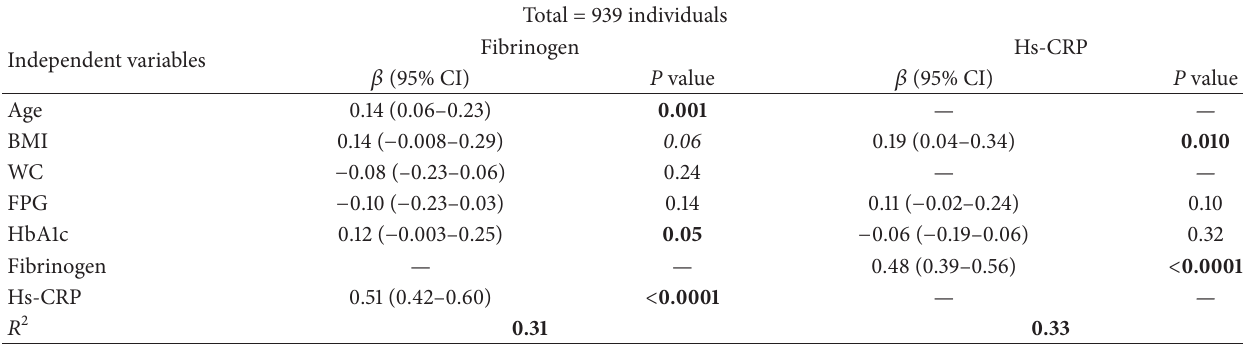
Dependent variables are listed horizontally, and independent variables are listed vertically; 𝛽 : standardized correlation coefficients (95% confidence interval); 𝑅 2 : adjusted determination coefficient (significant in bold = 𝑃 ≤ 0.05 ); BMI: body mass index; WC: waist circumference; FPG: fasting plasma glucose; HbA1c: glycosylated hemoglobin; hs-CRP: high sensitivity C-reactive